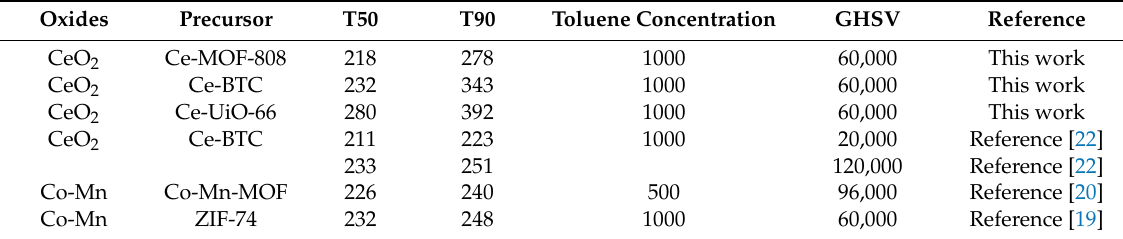
Figure 8. The combustion curves of 1000 ppm toluene in air ( a ) catalyzed by CeO 2 -MOFs at a GHSV of 60,000 mL/(g·h), and ( b ) for CeO 2 -MOF-808 at different GHSV from 30,000 mL/(g·h) to 120,000 mL/(g·h). Table 3. The catalytic performance of transition metal oxides derived from MOFs.